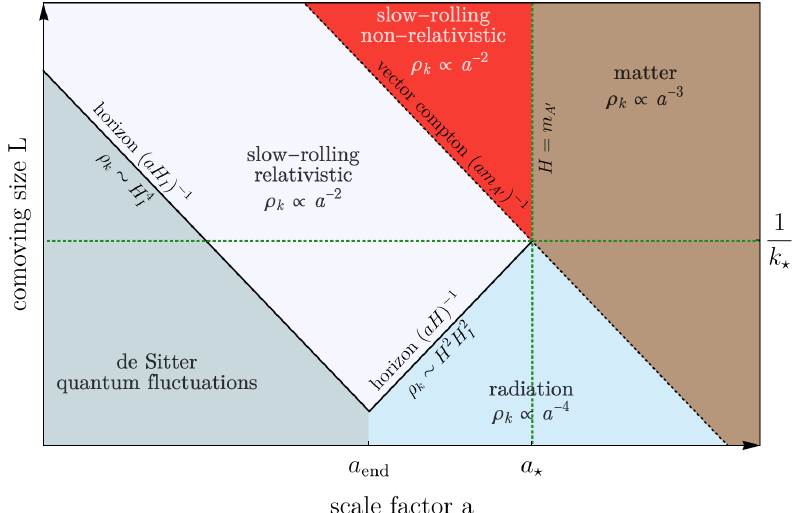
Figure 2. Evolution of the energy density in the scenario of [10]. Modes of the vector field are labeled by a constant wavenumber k and evolve horizontally from left to right. A set of modes around a given k leave the horizon while relativistic during inflation with an energy density ∼ H 4 they evolve in time, the modes go through different regimes depending on the hierarchy between the physical wavenumber k/a , the size of the cosmological horizon H − 1 , and the Compton wavelength m − 1 of the vector particle. The energy density contained in the modes redshifts according to those A 0 regimes. Mode oscillations are essentially frozen until the mode either re-enters the horizon after the end of inflation, or H decreases below m A 0 , whichever occurs first. Ref. [10] studies in detail the scaling of frozen modes. Modes are naturally divided into two sets: those that re-enter the horizon before H = m A 0 (and therefore while still relativistic), and those that become non-relativistic before H = m A 0 . In the non-interacting theory, the late-time energy density is dominated by the set of modes with comoving wavenumber k ? that cross the horizon just as H = m A 0 (dotted green lines). Ref. [10] considers the case of instantaneous reheating (shown here), but the results are